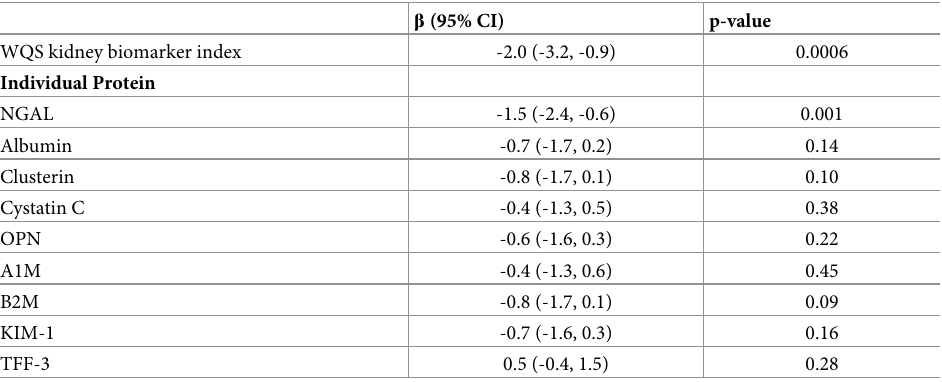
Table 3. Gestational age in days per decile increase in individual proteins and the kidney biomarker index. These linear regression models were adjusted for child sex, age, BMI, indoor smoking, and urinary